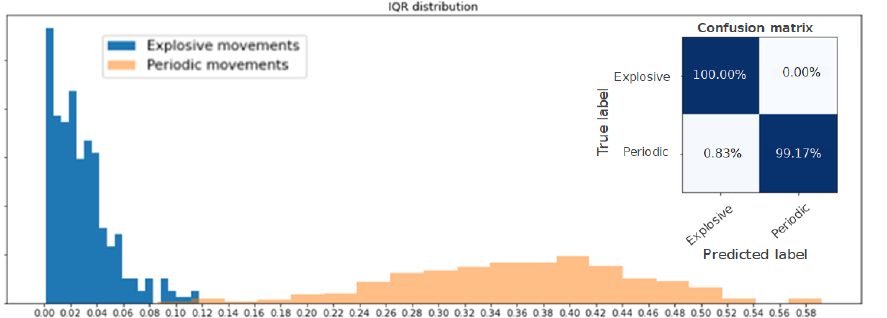
Figure 2. IQR distribution of explosive and periodic movements. On the top right, the confusion matrix of the periodic- vs. explosive-activity classifier based on a threshold of 0.12 on the